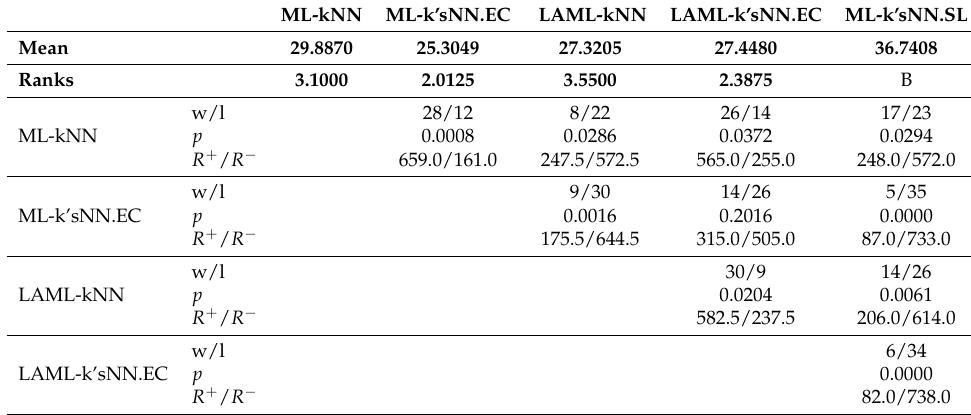
Table 7. Comparison of the different methods using coverage metric.